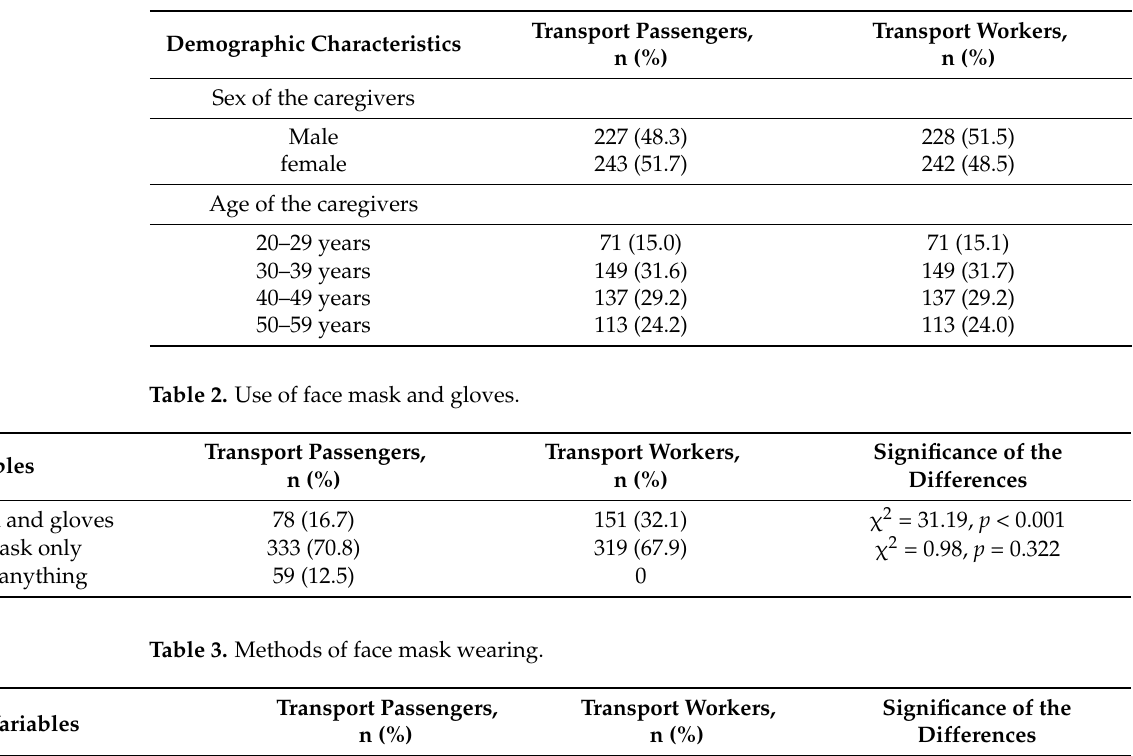
Table 1. Characteristics of the study population in public transport passengers and workers.